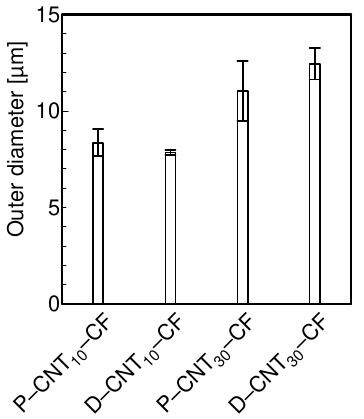
CNT grafted from thick Ni particle.